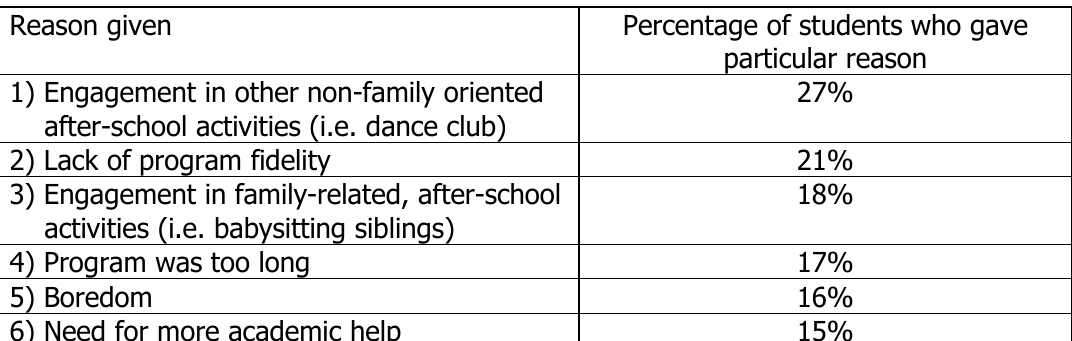
Top Six Reasons for Withdrawal,